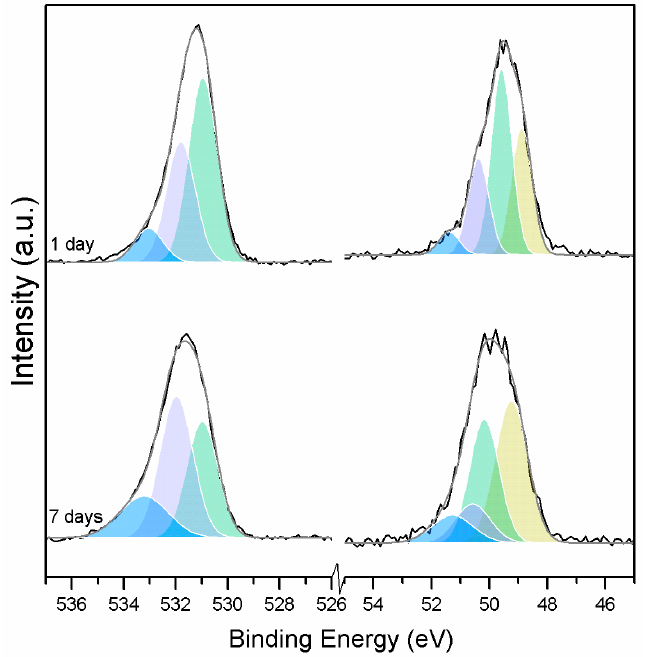
Figure 11. O1s ( left ) and Mg2p ( right ) peaks for samples exposed to 10% CO 2 for one and seven days. Materials 2017 , 10 , 75 Table 6. Mg2p peak information for samples exposed to 10% CO 2 for one and seven days. Mg2p O1s